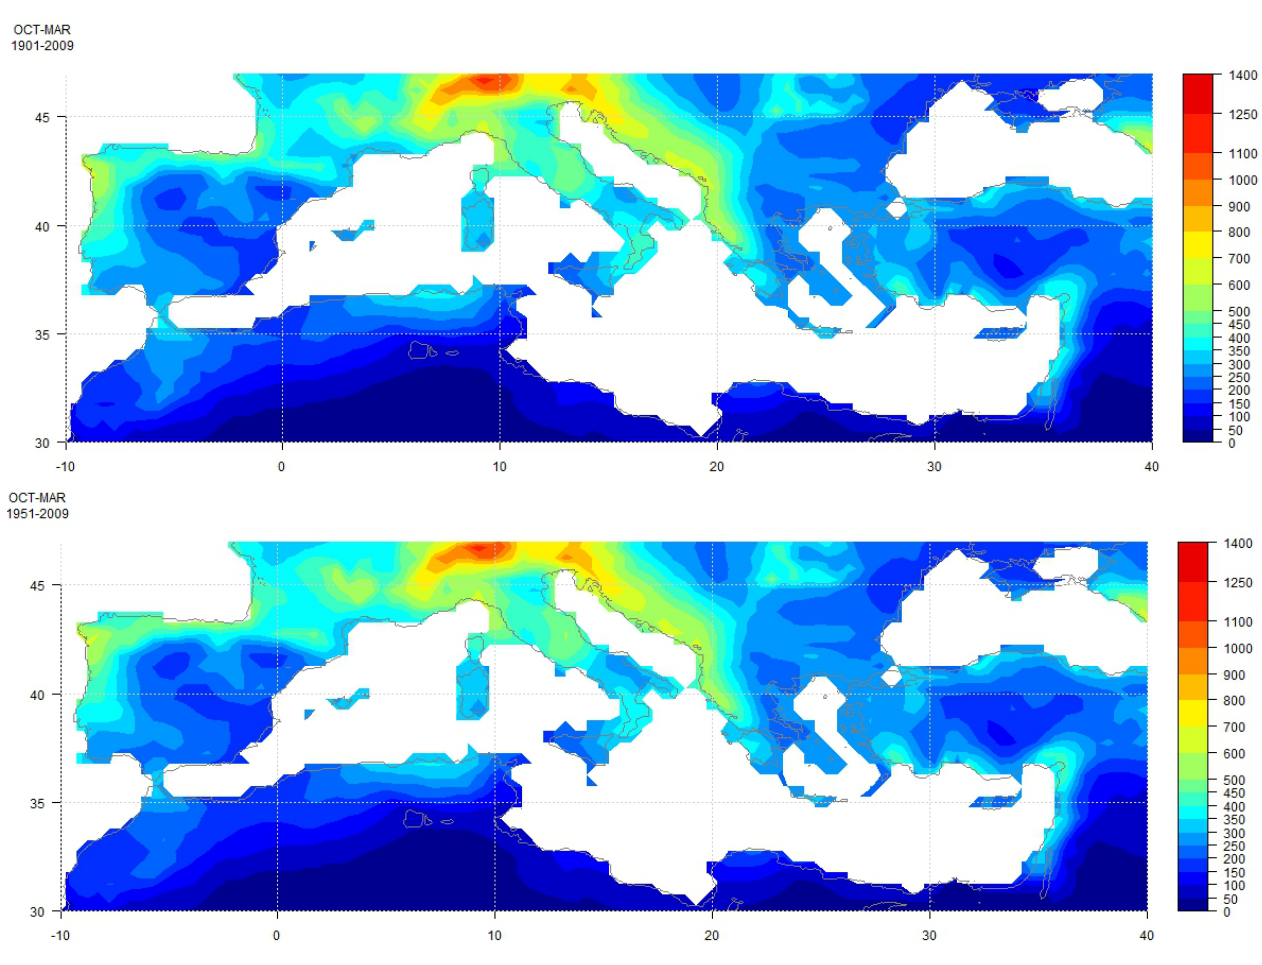
Fig. 2. Spatial distribution of mean precipitation for the rain season (October–March) concerning gridded datasets (CRU TS 3.1), for 1901– 2009 (upper graph) and 1951–2009 (lower Figure 2 . Spatial distribution of mean precipitation for the rain season (October – March) 1 concerning gridded datasets (CRU Τ S 3.1), for the entire twentieth century (1901-2009) 2 (upper graph) and 1951-2009 (lower graph). 3